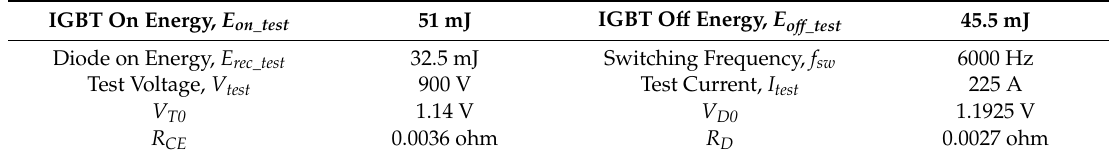
Table 1. Insulated gate bipolar transistor (IGBT) parameter of the converter.